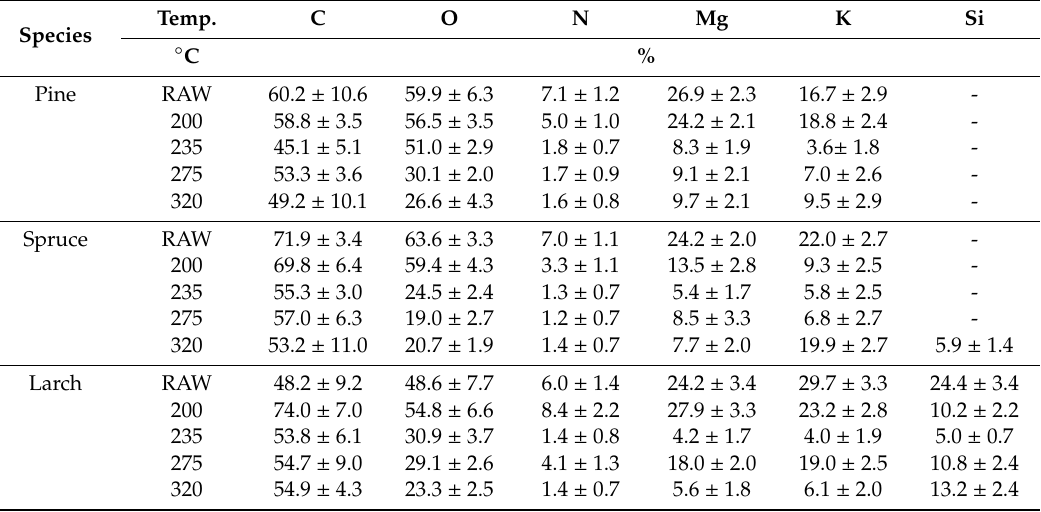
Table 3. Mean percentage shares (%) of individual elements at the surface of cones torrefied at 200–320 ◦ C (RAW—raw